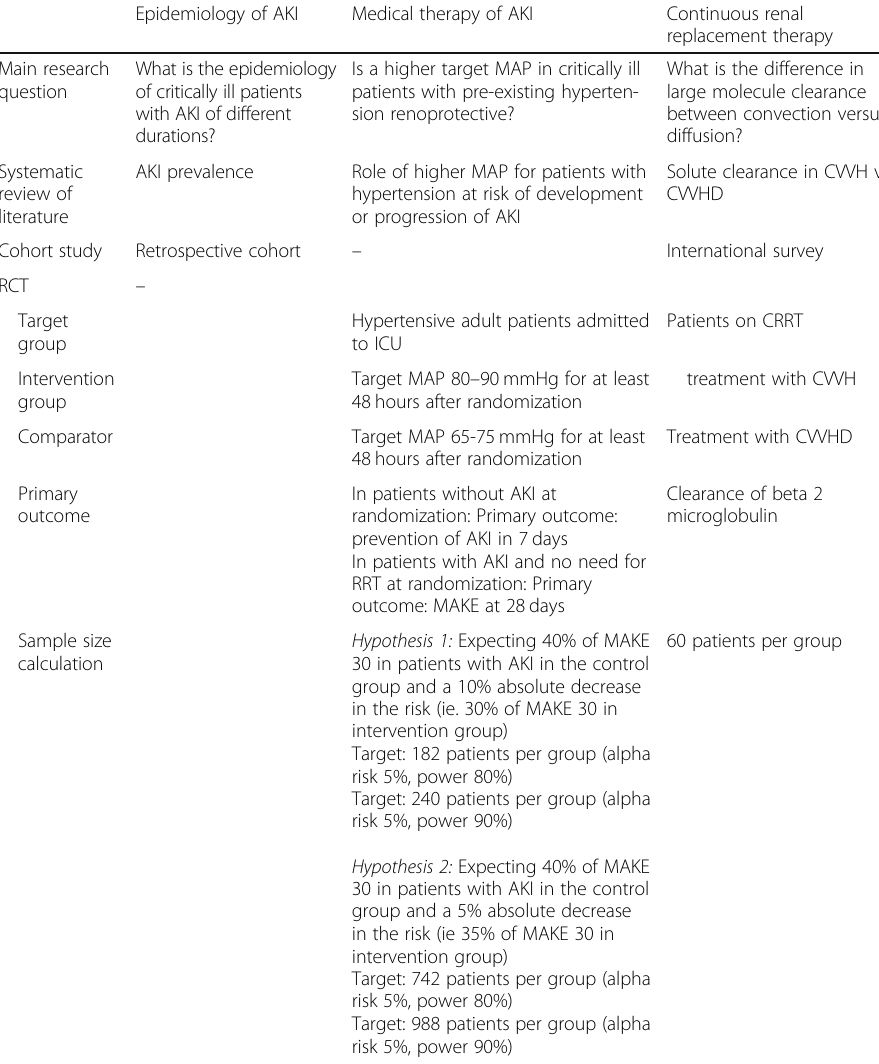
Table 1 Summary of research projects proposed by the ART